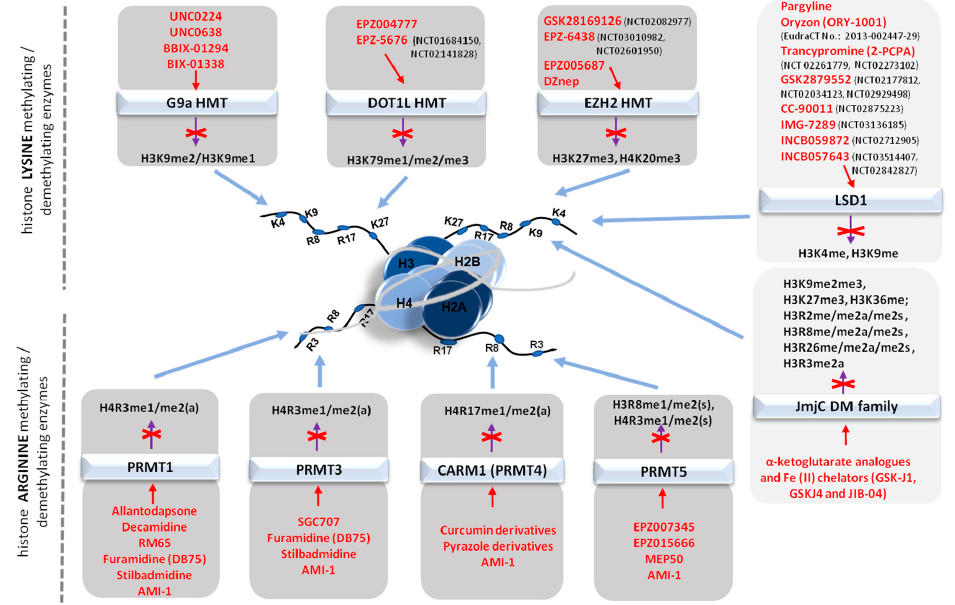
Figure 4. Schematic representation of the modifications of histone core proteins methylation status by lysine and arginine methyltransferases/demethylases inhibitors . The methylation status of histones is modified by specific molecules with approved inhibitory abilities verified in multiple in vitro/in vivo studies or tested in clinical trials (the number of trials has been included in brackets) toward lysine and arginine histone methyltransferases/demethylases. Inhibitory, biochemical and biological properties of indicated inhibitors (distinguished by red font) are presented in the main text.